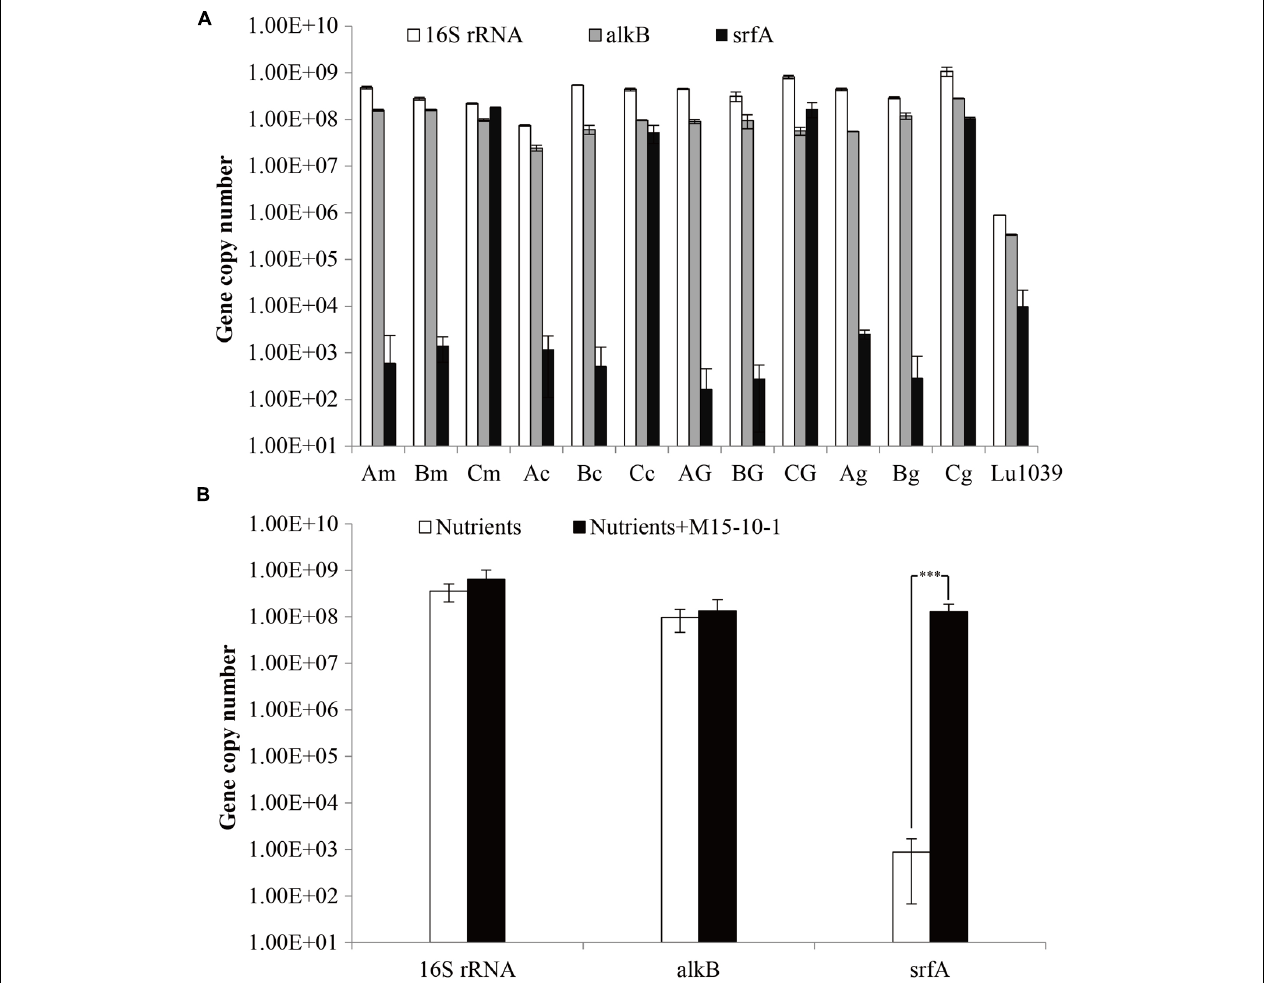
FIGURE 6 | Copy numbers (A) and average copy numbers (B) of 16S rRNA, alkB and srf A genes detected in the water samples stimulated by nutrients or in combination with Bacillus subtilis M15-10-1. A: microcosm containing nutrients; B: microcosm containing nutrients and crude oil; C: microcosm containing nutrients, crude oil, and Bacillus subtilis M15-10-1; G: glucose; g: glycerol; m: molasses; and c: corn steep powder. ∗∗∗ The abundance of the gene was significantly different among water samples stimulated by nutrients or in combination with Bacillus subtilis M15-10-1 ( P < 0.0001).